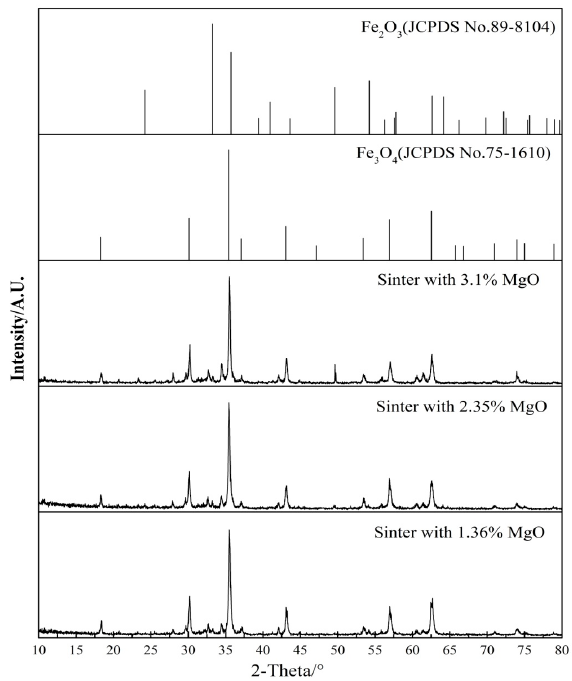
Figure 7. XRD patterns of sinter after reducing at 550 °C for 30 min.